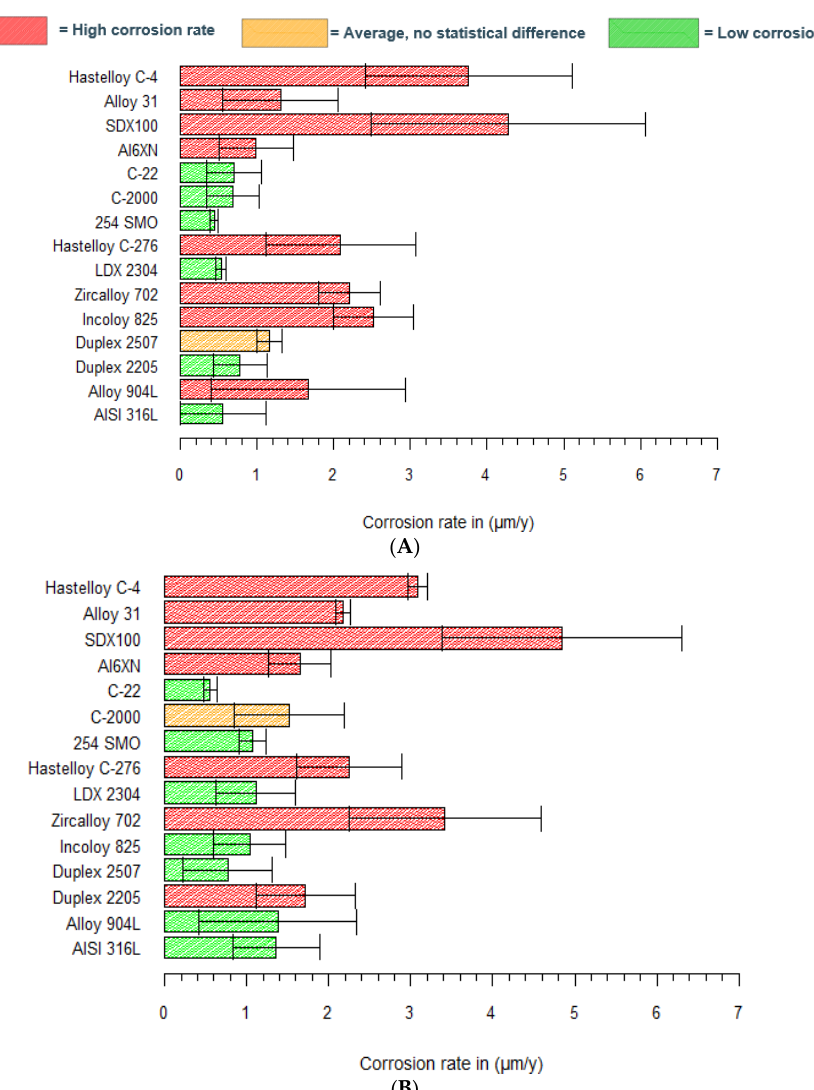
Figure 7. Uniform corrosion rates calculated by Tafel extrapolation, including the statistics of the Dunn tests for ( A ) pH 12.5 with 1 M Cl − ; and ( B ) pH 13.5 with 1 M Cl − .